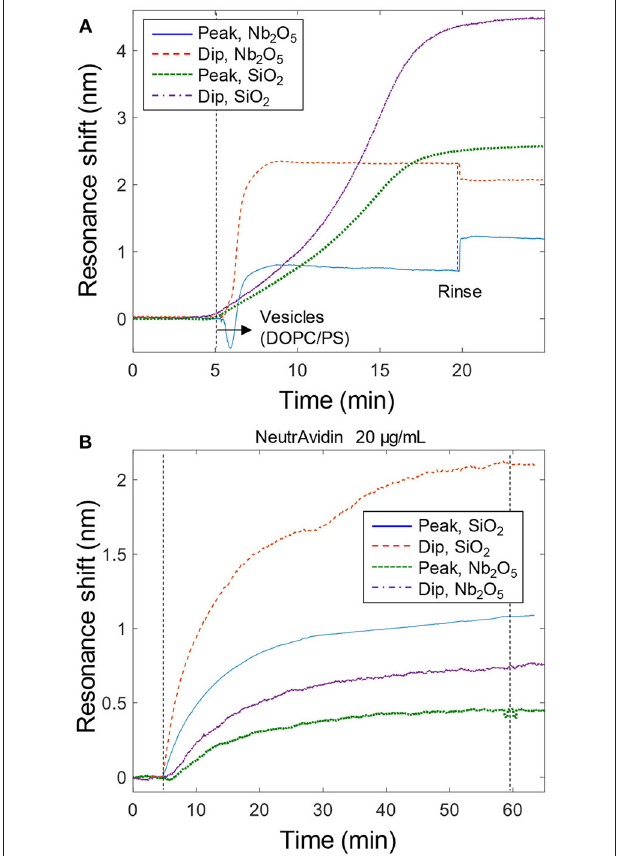
FIGURE 3 | Bilayer formation and model protein binding. (A) Signals from bilayer formation (with vesicles containing PS) on the nanoplasmonic sensor surfaces. An ∼ 5 times higher concentration of vesicles ( ∼ 300 µ g/mL) were introduced to the Nb 2 O 5 structures, which is why a step-like change is observed upon liquid exchange (This is due to light scattering by vesicles in the bulk). (B) Example data of binding of NeutrAvidin to bilayers with biotinylated lipids. Peak and dip signals are shown for both